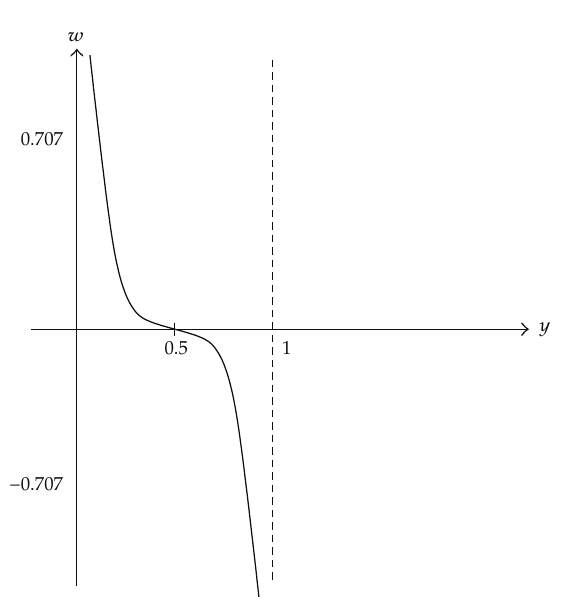
Figure 3: Graph of b for Example